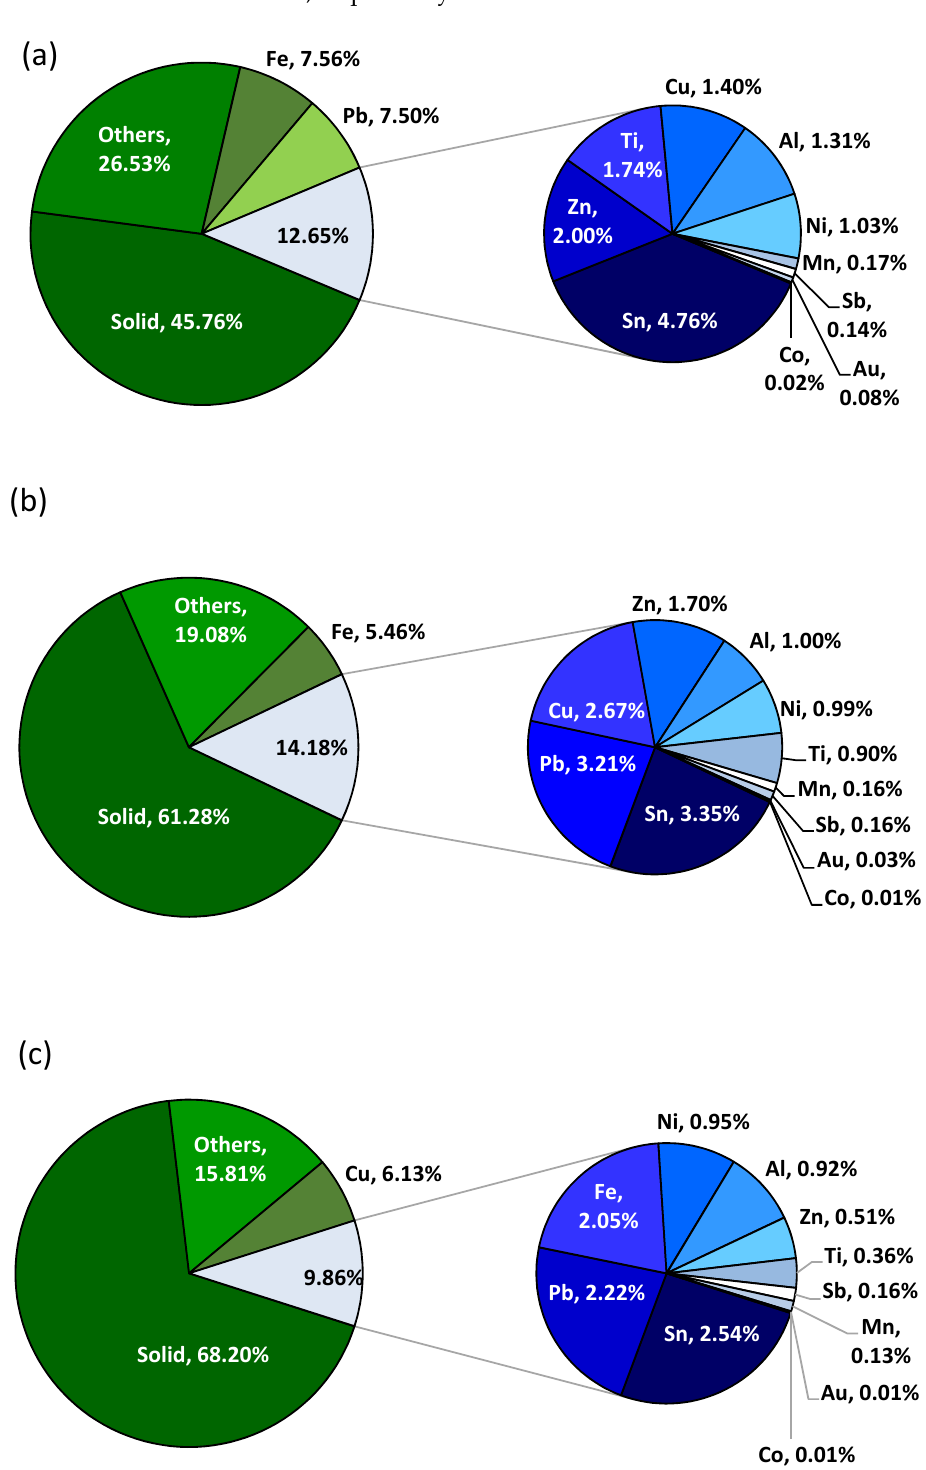
Figure 7. Content of metals in raw materials according to the results of ICP-OES analysis of